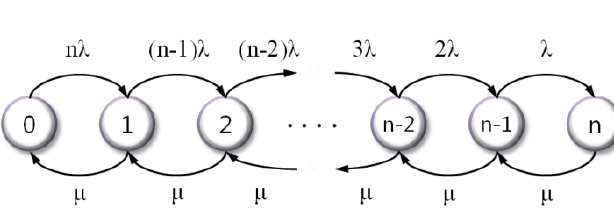
Figure 7. The state diagram.